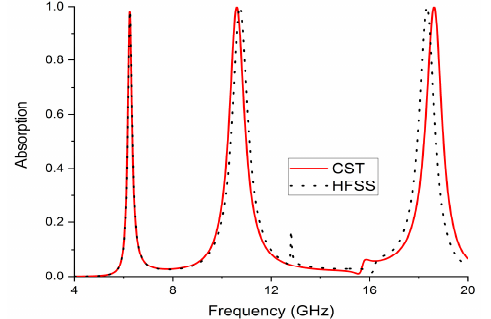
Figure 13. Absorption response using the CST and HFSS simulators. Table 3. Comparison table of proposed MAs in the previous